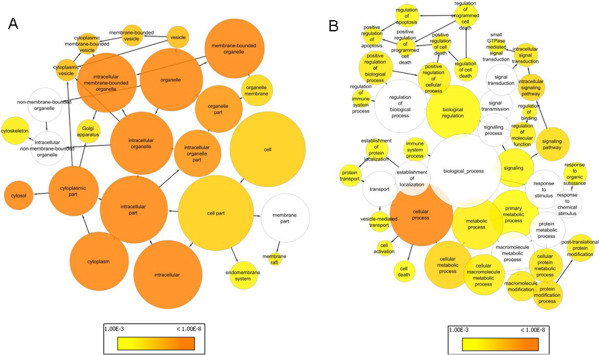
Gene ontology analysis of 4214 array genes associated with smoking. The 4214 smoking-associated genes were analyzed using BINGO to identify significant biological processes. Significant processes (p < 0.001 after FDR correction) are colored with the gradient of p values reflected in the colors as indicated, and the biological process annotated. (A) Cellular component ontological terms (B) Biological Process ontological terms.